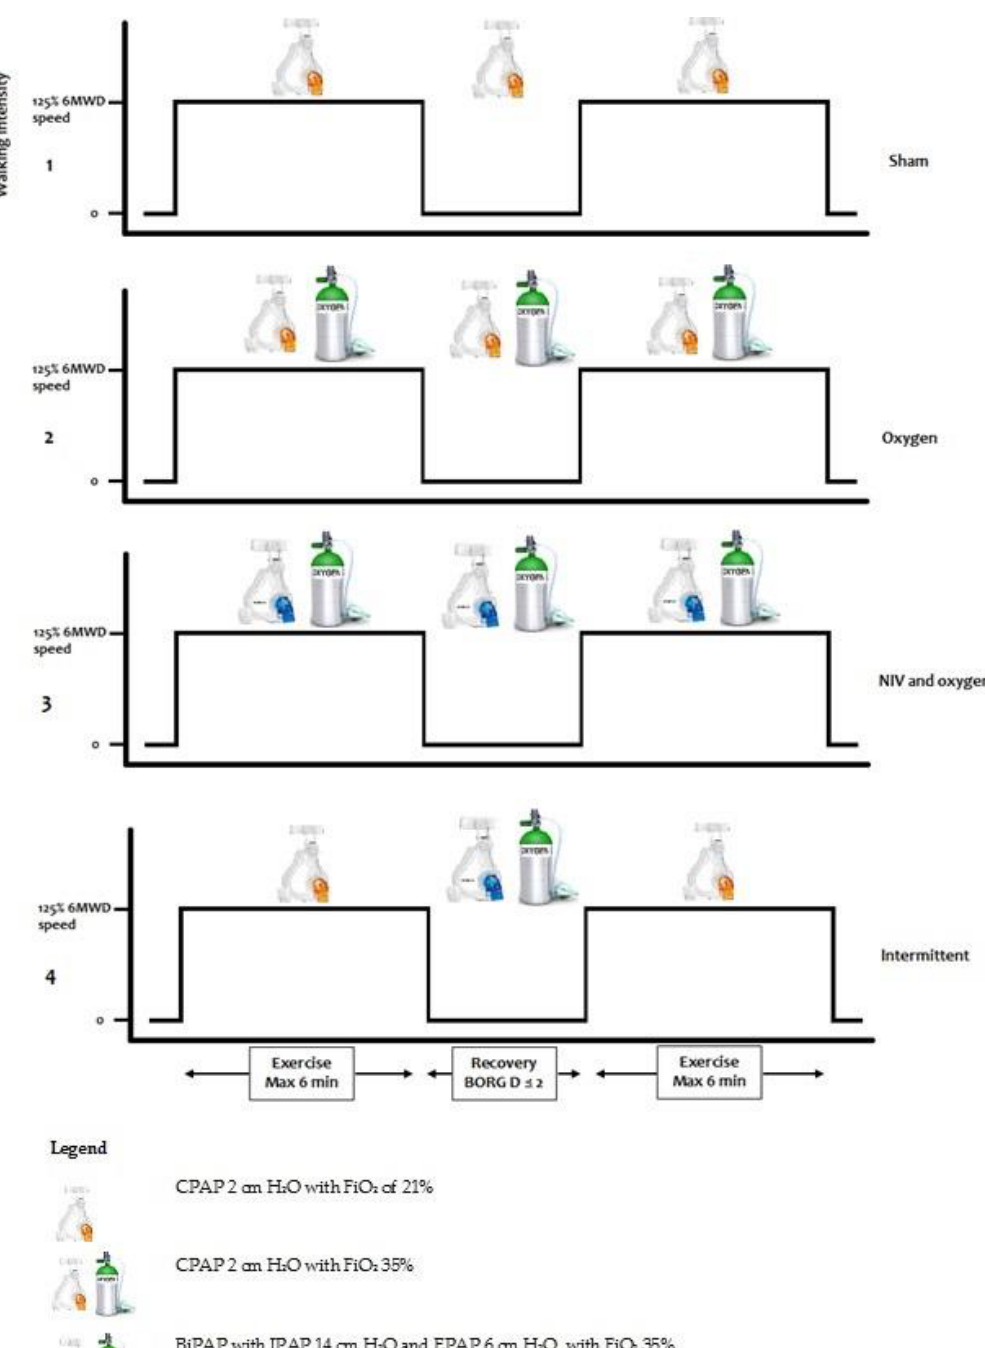
Figure 1. Interventions. Abbreviations: 6MWD = six-minute walking distance, NIV = non-invasive ventilation, BORG D = Borg dyspnea, CPAP = continuous positive airway pressure, BiPAP = bilevel positive airway pressure, FiO 2 = inspired oxygen fraction.